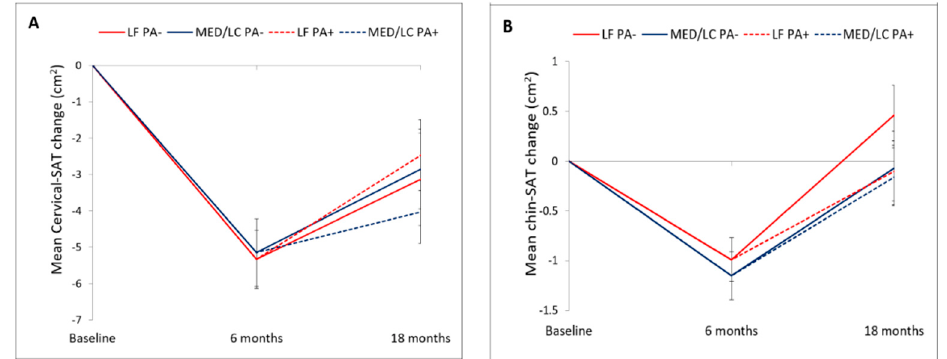
Figure 3. 18 months cervical and chin SATs trajectories across lifestyle intervention groups. Panel ( A ) presents the dynamics of cervical-SAT and panel ( B ) dynamics of chin-SAT. Vertical bars indicate standard errors. There were no statistically significant differences between the intervention groups. LF, low-fat; MED/LC, Mediterranean/low-carbohydrate-; PA, physical activity. Table 2. 18 months changes in cervical and chin SATs across lifestyle intervention groups.